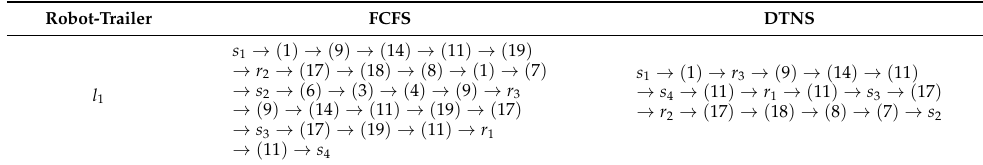
Table 7. Paths obtained by FCFS and DTNS under the condition of one robot-trailer in scenario 1. Robot-Trailer